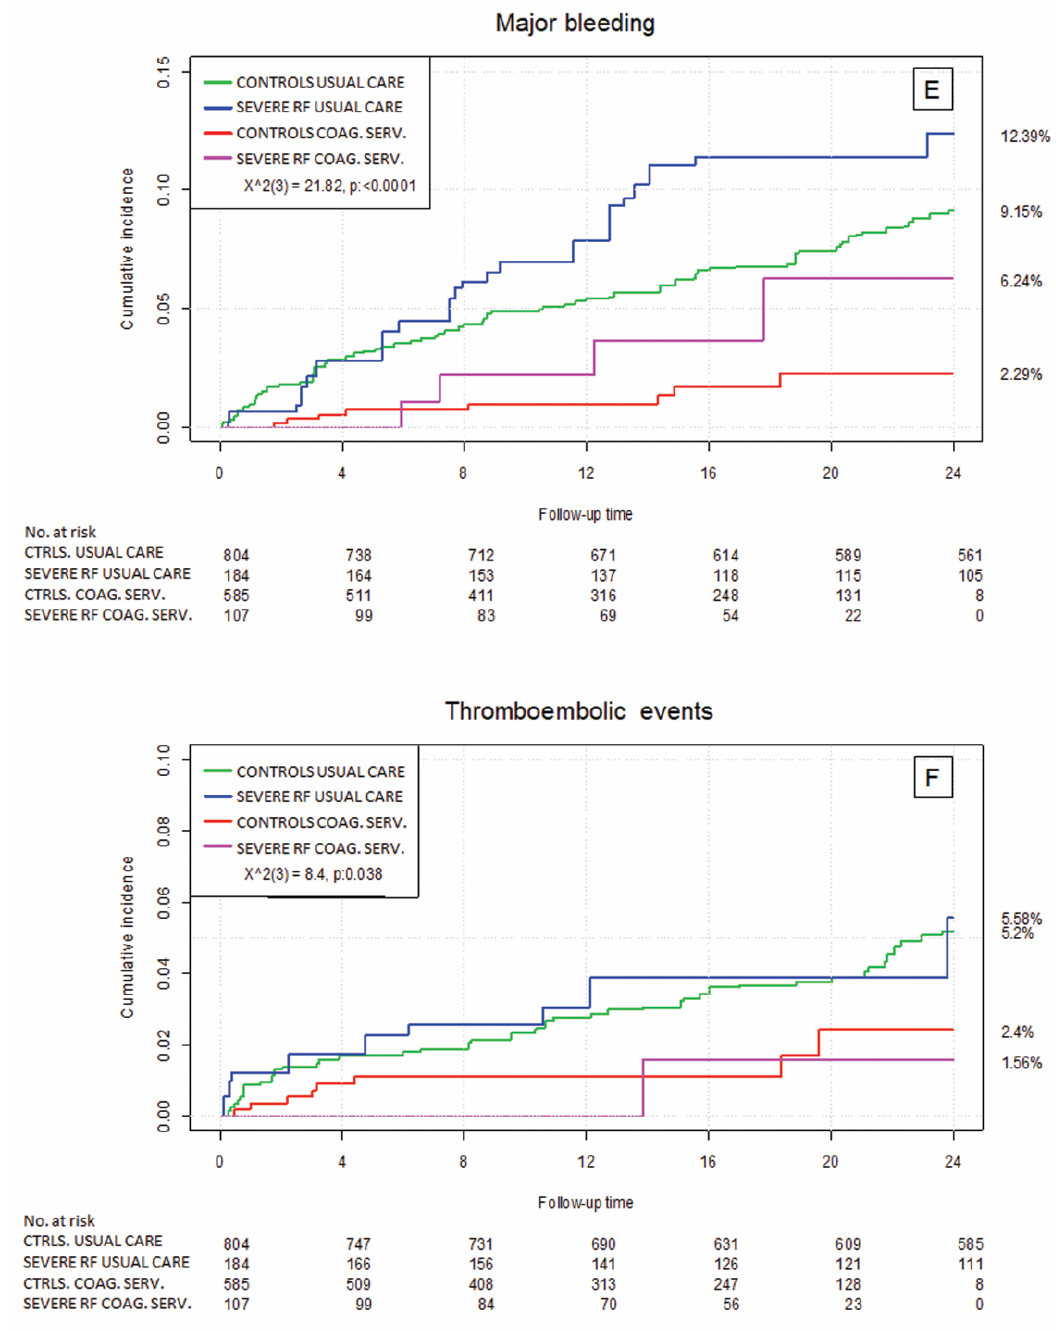
Figure 3. The propensity score adjusted (weighted by inverse probability weights) cumulative incidence plots of the safety endpoints and outcome measures comparing severe renal failure patients and controls in standard care and a coagulation service. ( A ): long-term outcome, ( B ): death, ( C ): hospitalizations, ( D ): all clinically relevant bleeding, ( E ): major bleeding, ( F ): thromboembolic events; Ctrls. Usual care: patients without severe renal failure (RF) managed in usual care; Severe renal failure usual care: patients with severe renal failure managed in usual care; Ctrls. coag. serv.: patients without severe renal failure managed in a coagulation service; severe RF coag. serv.: patients with severe renal failure managed in a coagulation service.